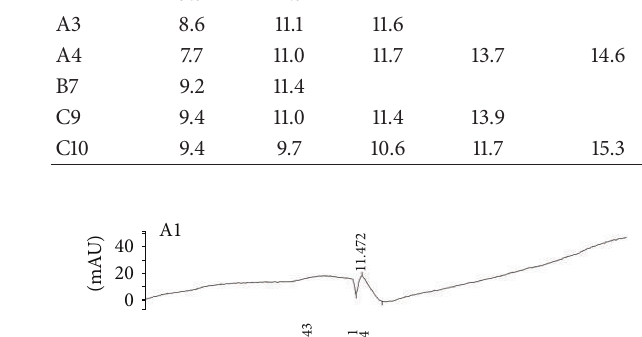
Figure 1: FTIR spectrum of samples A1–A4.